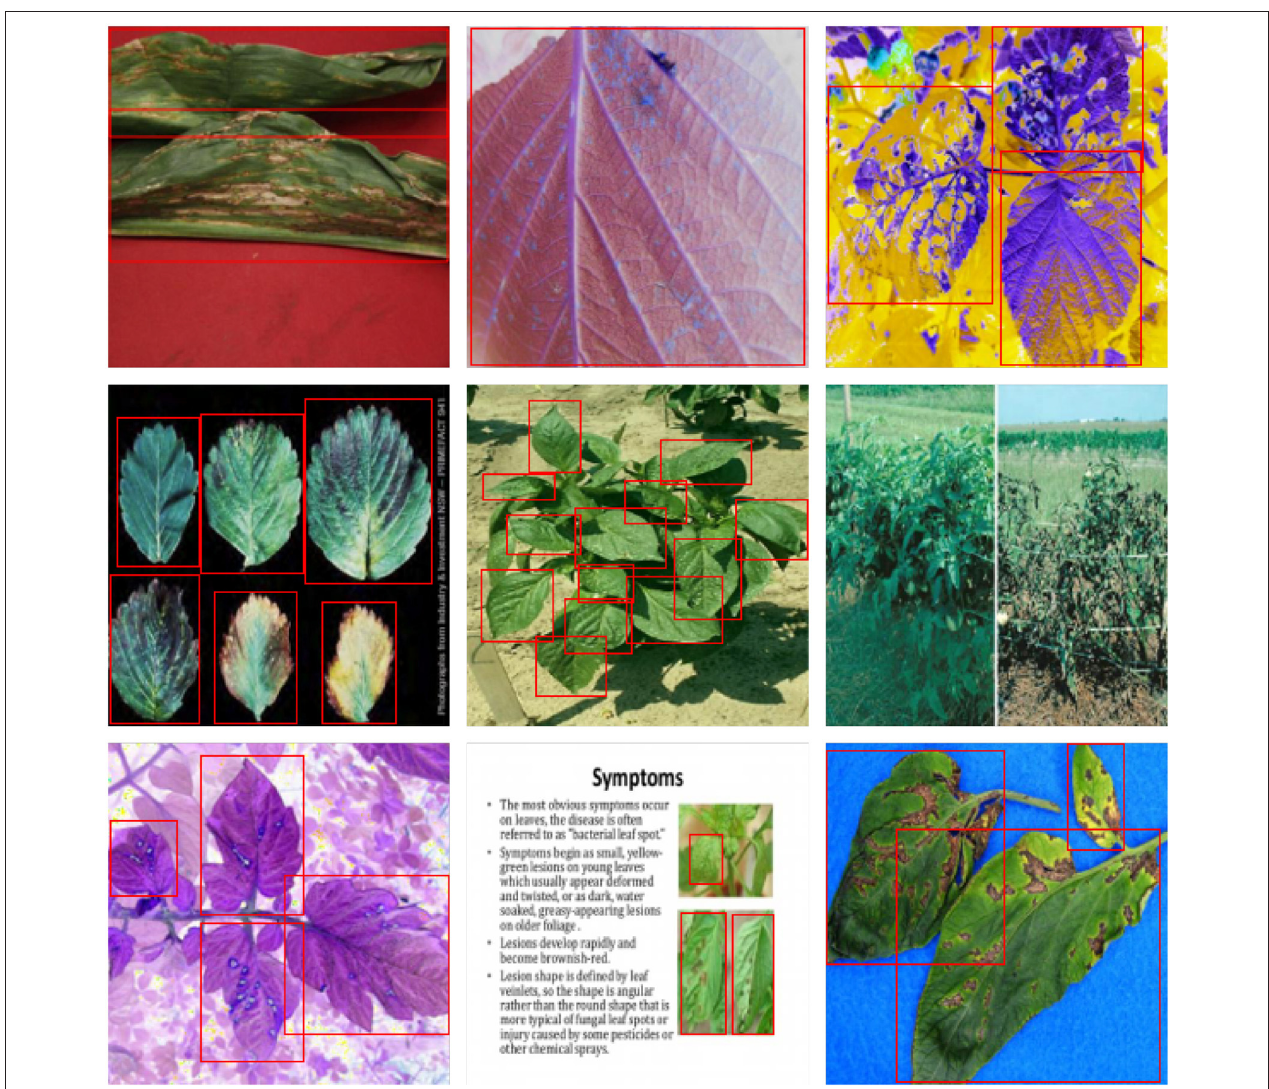
FIGURE 6 | The ground truth in the dataset.